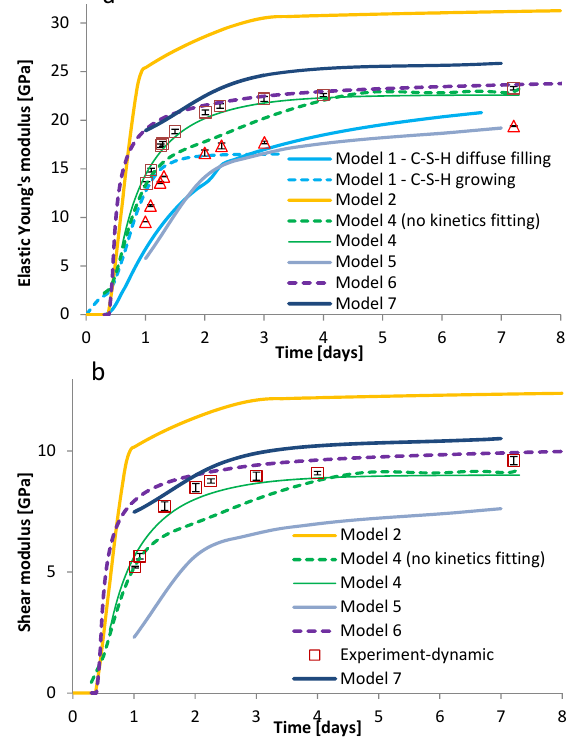
Figure 3. Comparison of the experimental data and simulation results for different models for a) dynamic and static elastic Young’s modulus and b) dynamic shear modulus. Experimental results from the dynamic measurements are presented with open square markers and from the static measurements with open triangle